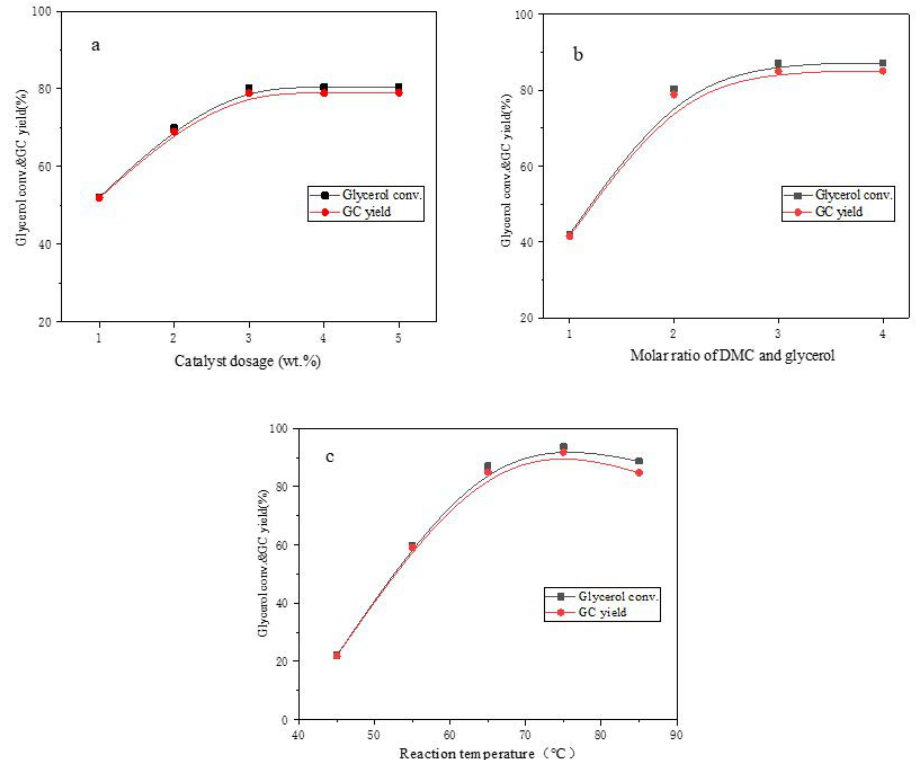
Figure 8. Effect of catalyst dosage ( a ), molar ratio of DMC to glycerol ( b ) and reaction temperature ( c ) on